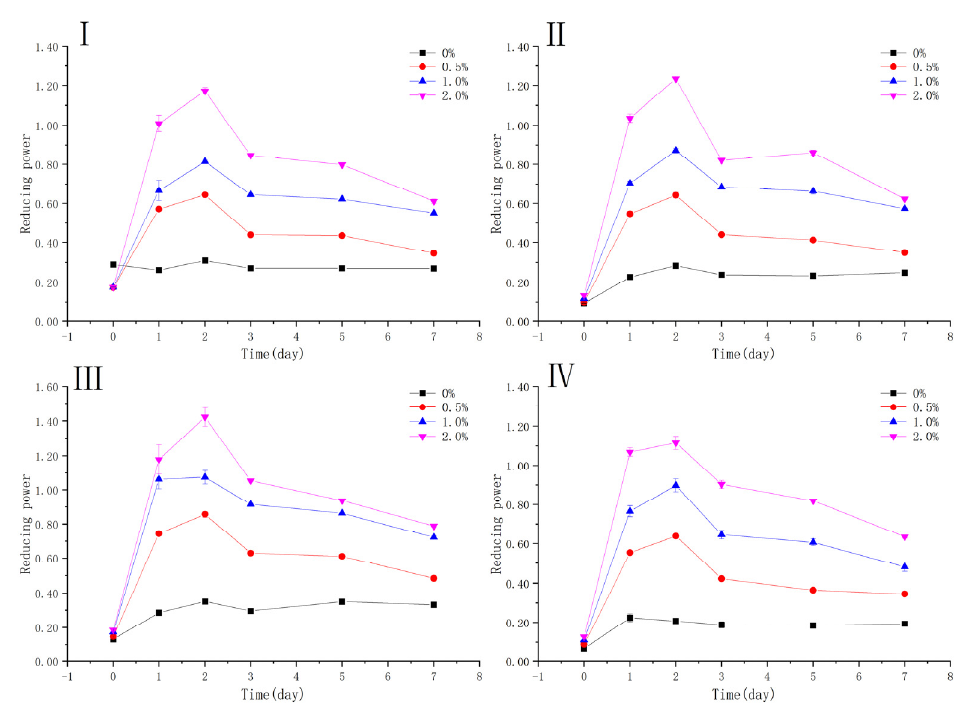
Figure 11. The reducing power of autoxidation browning products of ( I ) Catechin ( II ) Epicatechin ( III ) Caffeic acid ( IV ) Chlorogenic acid under the effect of different concentrations of eugenol.